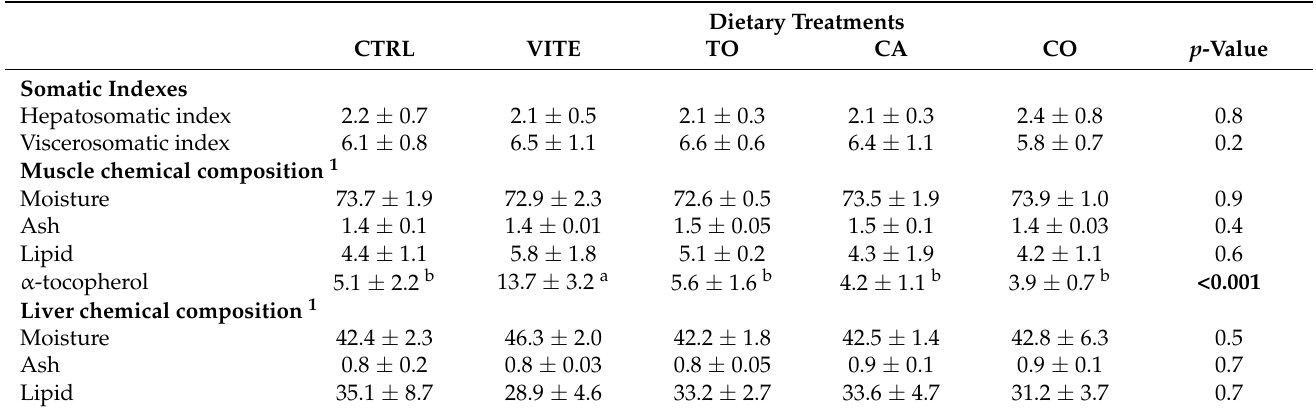
Table 4. Somatic indexes and chemical composition of muscle and liver of Dicentrarchus labrax fed with the experimental diets for 87 days.